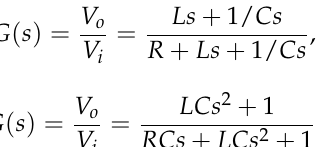
coefficients of the digital notch filter. These vectors are [0.9975 − 1.9911 0.9975] and [1.0